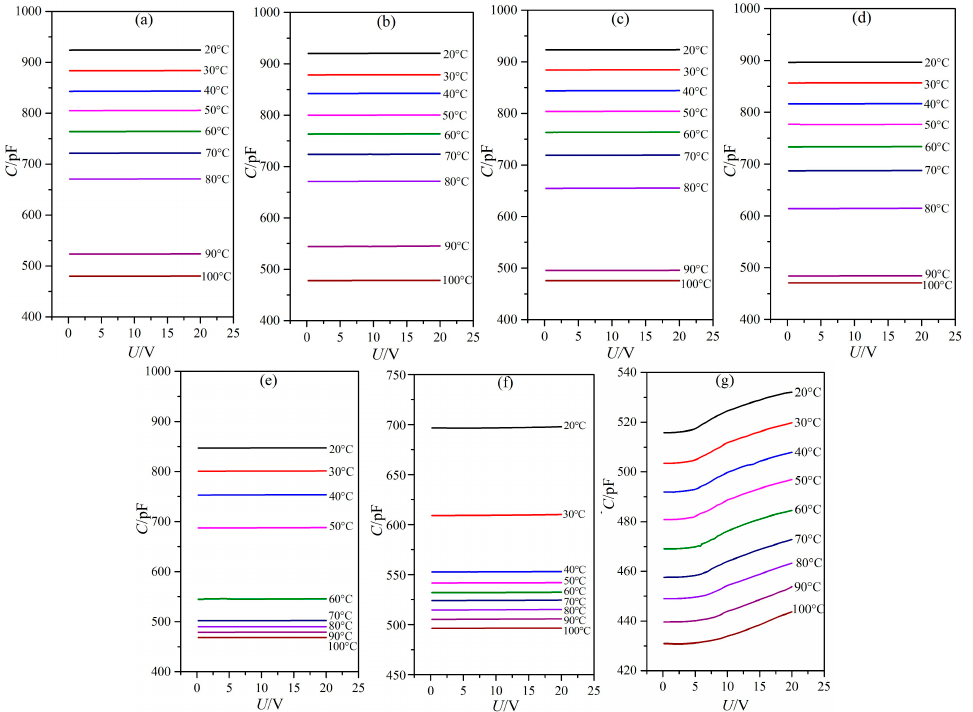
Figure 4. LC cell capacitance versus voltage with frequency of 1 kHz for vertically aligned nematic (VAN) cell under different temperatures and doped γ -Fe 2 O 3 nanoparticle concentrations of ( a ) 0.0; ( b ) 0.02; ( c ) 0.048; ( d ) 0.145; ( e ) 0.515; ( f ) 0.984; and ( g ) 2.6 wt %.